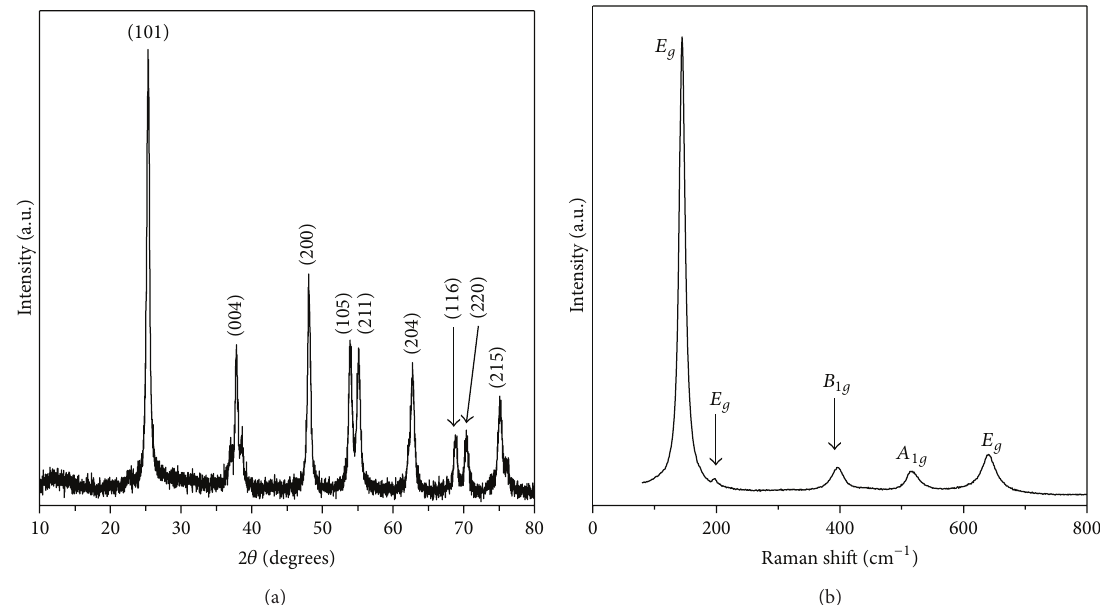
Figure 1: (a) Powder XRD of TiO 2 synthesized by sol-gel at 450 ∘ C. (b) Raman spectrum of TiO 2 powder obtained at 450 ∘ C.